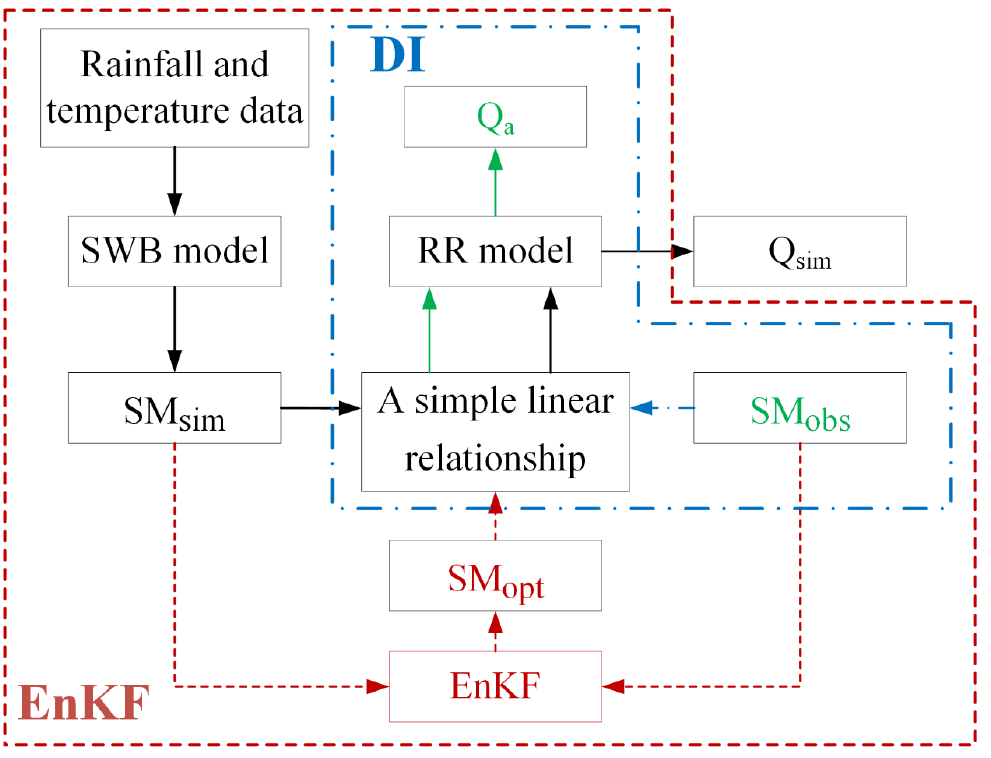
Figure 4. Flowchart of DA for soil water storage using the DI method (blue) and the EnKF method (red) coupled with the MISDc model; the green parts are common between the two methods.